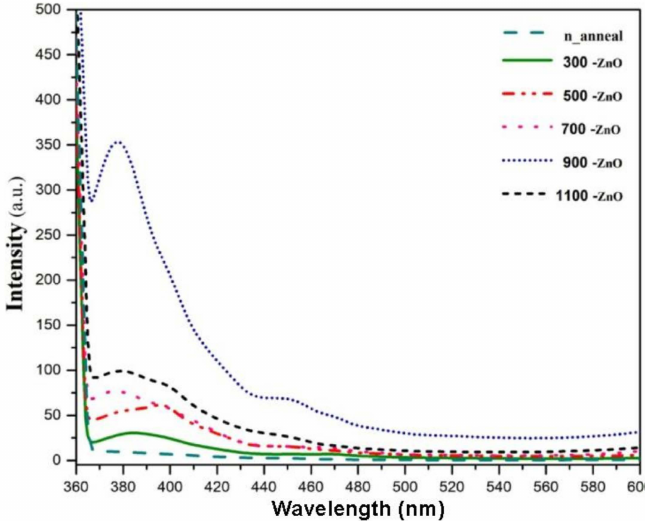
Figure 12. PL spectroscopy of Zn and ZnO nanostructured thin films